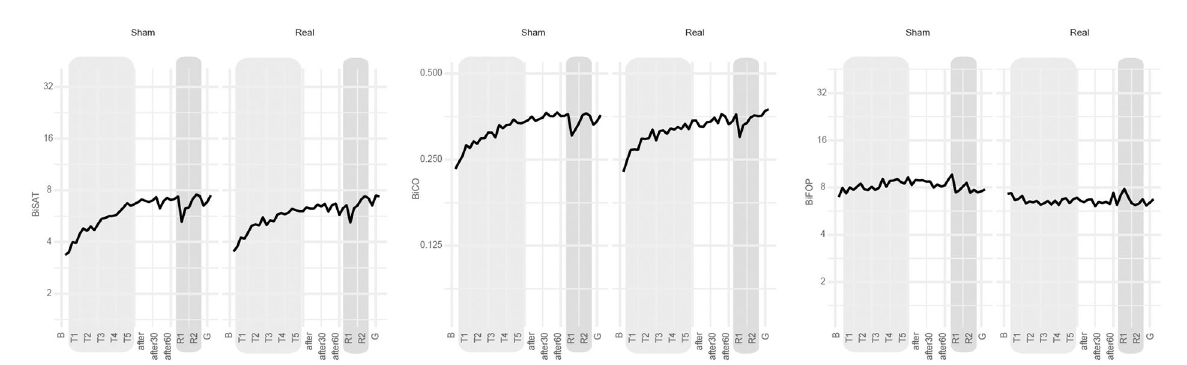
FIGURE3 Main results. Evolution over time of biSAT (in a.u.), biCO (in a.u.) and biFOP (in N) on the bimanual CIRCUIT task at the group level (bold line: group’s mean). B: baseline, T1-T5: bimanual training under sham or real tDCS, after-after30-after-60: evaluation immediately after intervention and 30 and 60min later, respectively; R1-R2: retention blocks 1 and 2 at 1 week after intervention, respectively; G: generalization block (new